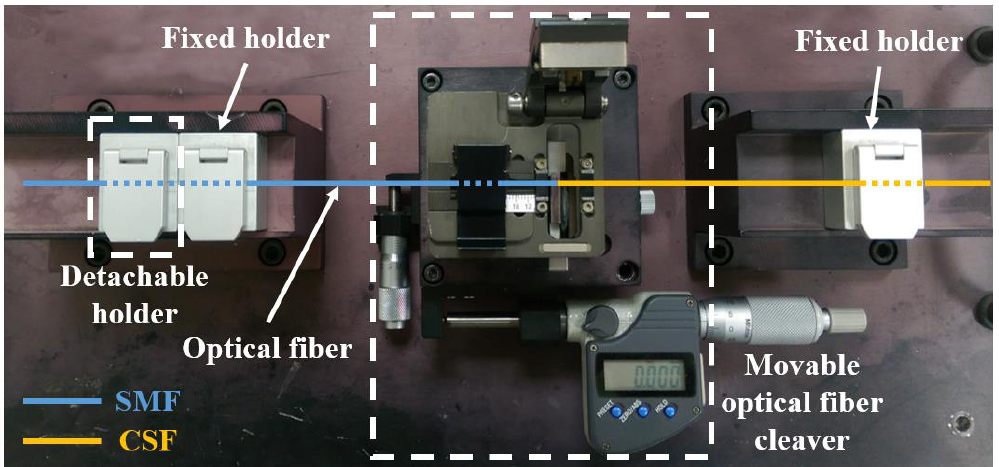
Figure 5. Photograph of the precise cleaving system used to control the length of the LOF’s beam expansion region ( L c ). The cleaver could be shifted laterally with a precision micrometer.